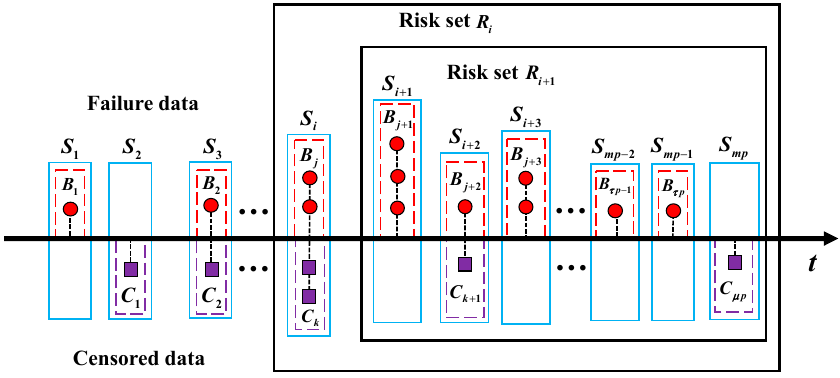
Figure 2. The definition in partial likelihood estimation method.